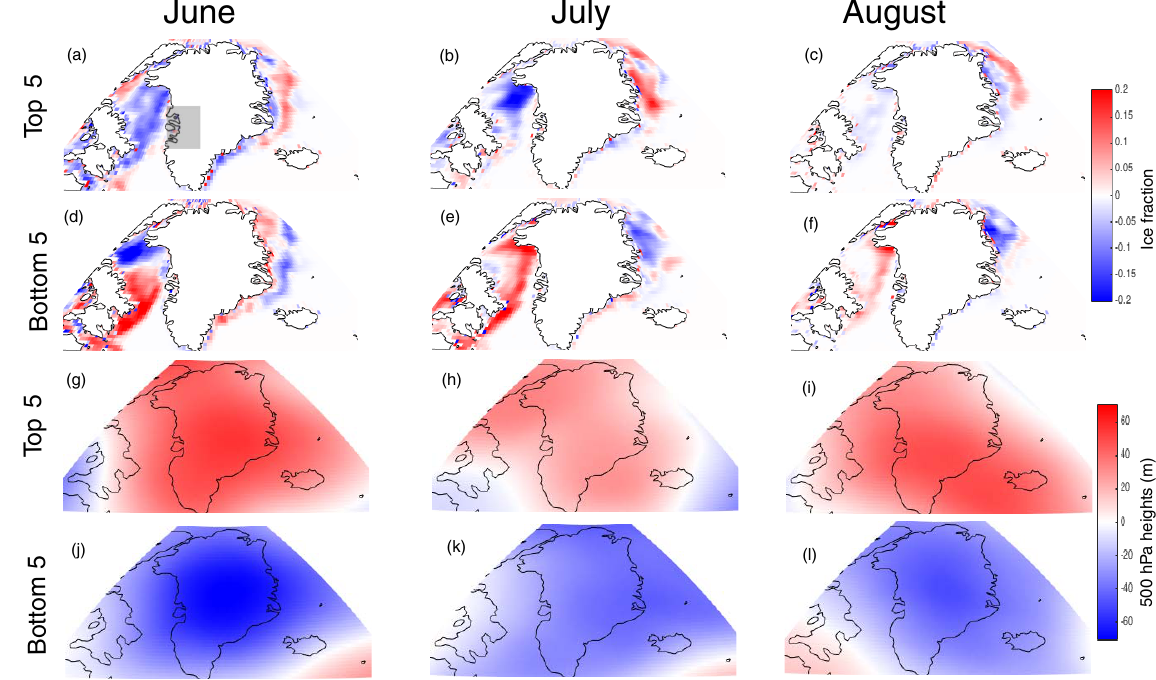
Figure 11. De-trended anomalies of SIC ( a–f ) and 500hPa geopotential heights ( g–l ) averaged over the 5 highest and lowest melt years in June, July, and August as indicated by de-trended meltwater production anomalies in the indicated gray region of the ice sheet. Units are ice fraction ( a–f ) and meters ( g–l